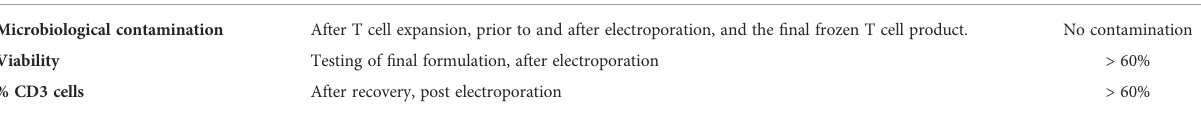
TABLE 2 List of release criteria for each cellular product batch to be used in the T-RAD clinical study.